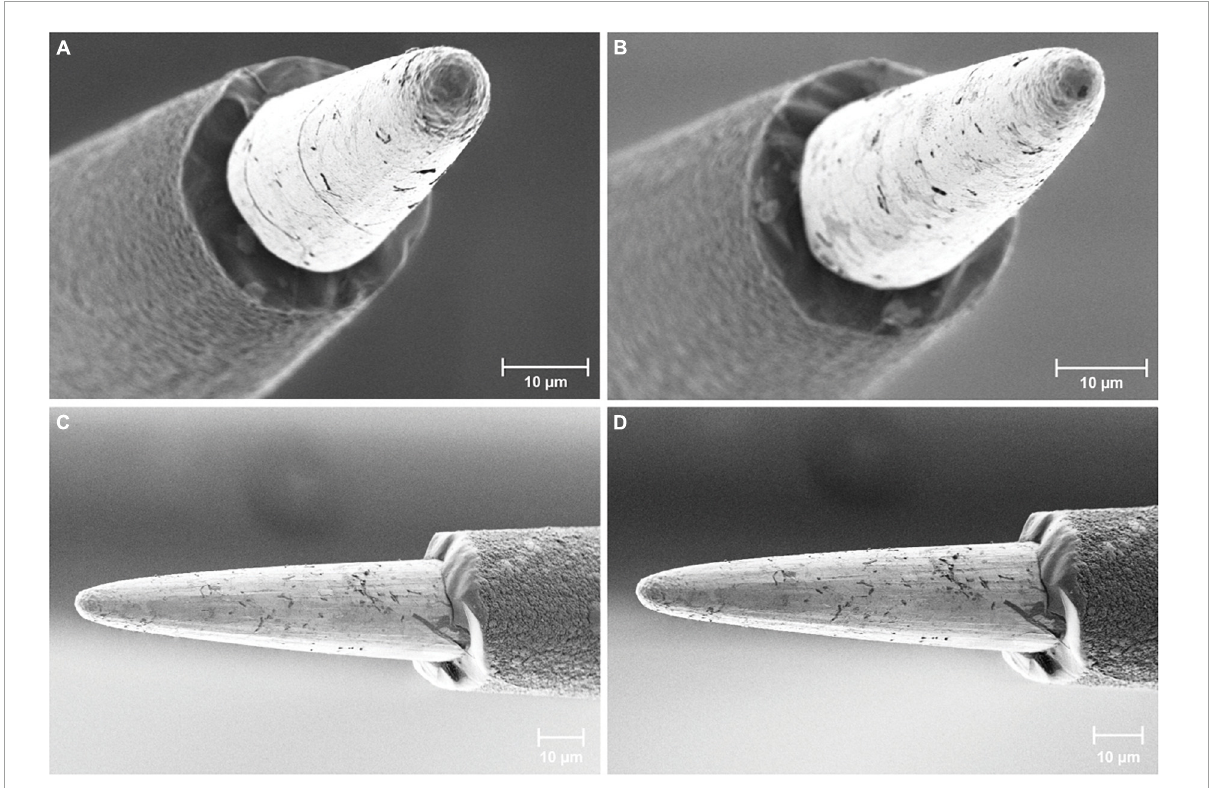
FIGURE4 Scanning electron microscopy images of AIROF electrodes and Parylene-C encapsulation. Images show four different electrodes after 24 days in LP-PBS: two pulsed electrodes (A) E11 and (B) E12 from WFMA device W0089_63_152, and two unpulsed electrodes (C) and (D) from WFMA device